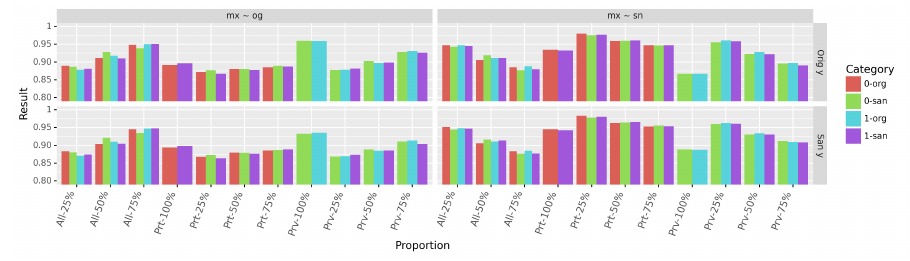
Figure 9. Agreement results (mean) of Gradient Boosting (GB) trained to predict the sanitized decision attribute on Adult Dataset. z ∼ t (each column) refers to the agreement obtained when using GB, respectively, on data z and data t , respectively: agr z ∼ t . org denotes the original version while san corresponds to sanitized profiles in the mixed data. Top: data (mixed, sanitized, or original) with original decisions, bottom: data with sanitized decisions (except the original dataset). Note that the standard deviation is less than 0.017.